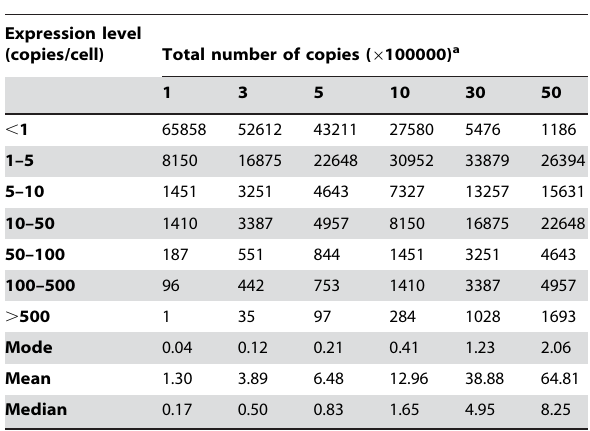
a The RAD is generated based on the pooled library with an estimated transcriptome diversity S =77,152. The number of unique transcripts in each expression level bin is calculated from numerical integral between corresponding intervals. The total transcript copies per cell are assumed for different complexity and the corresponding mode, mean, and median are calculated accordingly.